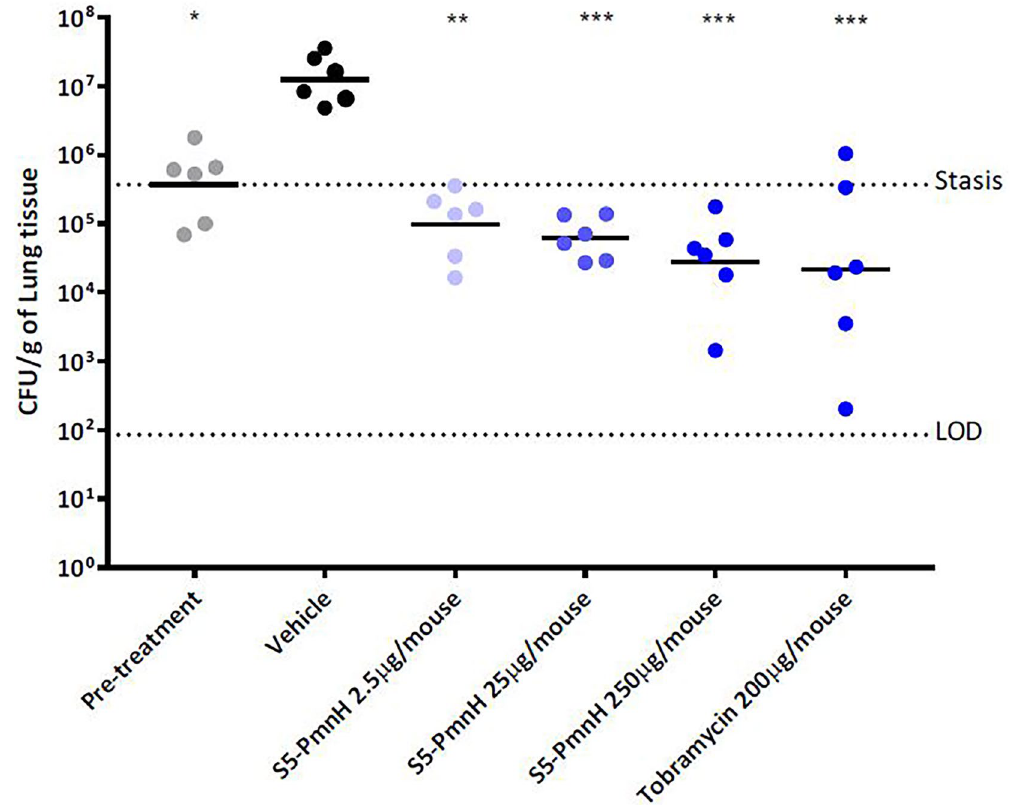
Figure 7. Scatterplot of terminal lung burden following IN infection with P. aeruginosa ATCC 27853. The data from the culture burdens were analyzed using appropriate non-parametric statistical models (Kruskal– Wallis using Conover-Inman to make all pairwise comparisons between groups) with StatsDirect (v. 3.3.3). The geometric mean burden of each treatment is indicated by the horizontal bar. *P ≤ 0.05, **P ≤